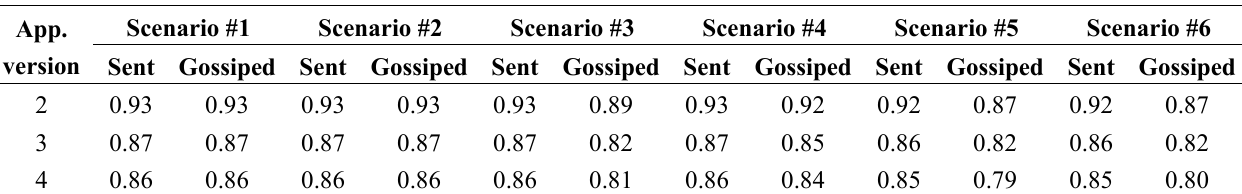
Table 5. Percentage of the energy saving for sending and receiving data in face of the original application